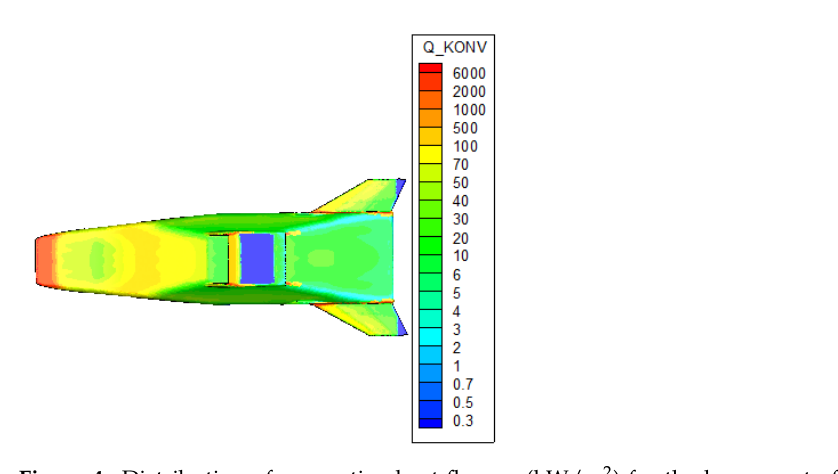
(kW/m 2 ) for the lower part of the X-43, Mach w q